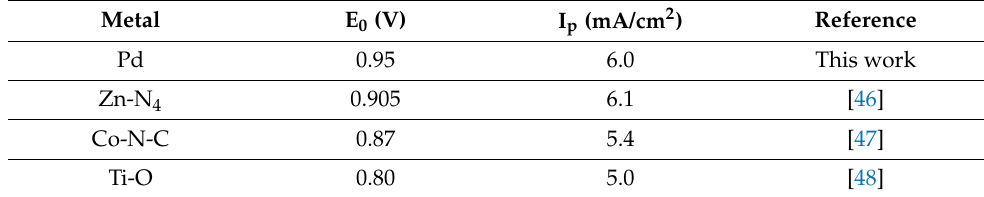
Table 2. Comparison of the catalytic performance of Pd with other